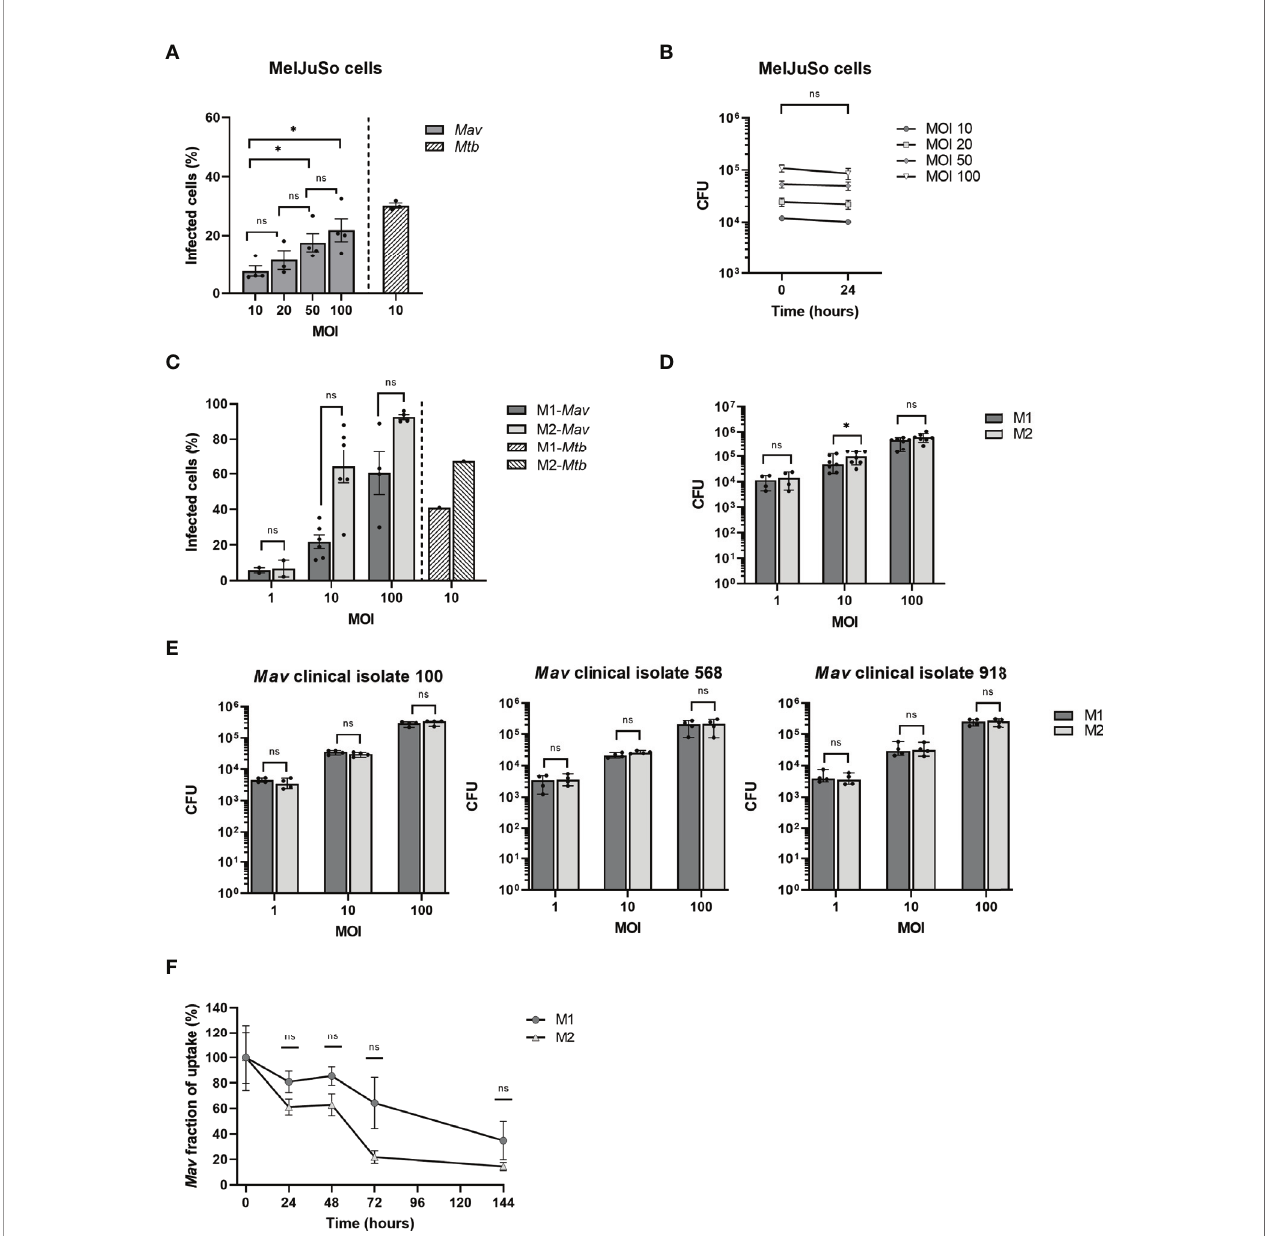
FIGURE 2 | Quanti fi cation of infection with and eradication of intracellular Mav Wasabi and/or clinical isolates by fl ow cytometry and/or CFU enumeration in MelJuSo cells and primary human macrophages. MelJuSo cells were infected with a multiplicity of infection (MOI) range of Mav Wasabi for 1 h. Directly after infection (0 h post-infection), the percentage of infected cells was determined by fl ow cytometry (A) and intracellular bacterial load was quanti fi ed using a CFU assay (B) . Bacterial elimination was monitored by lysing cells for CFU analysis 24 h post-infection (B) . The bars and whiskers represent the mean ± SEM of four different experiments. Differences were tested for statistical signi fi cant using one-way ANOVA with Tukey ’ s multiple comparison testing for infection rates between indicated MOI (A) or two-way ANOVA with Bonferroni ’ s multiple comparison testing for CFU between time points for each MOI (B) . Monocyte-derived human macrophages differentiated into pro-in fl ammatory macrophages (M1) or anti-in fl ammatory macrophages (M2) were infected with a multiplicity of infection (MOI) range (C, D) or an MOI of 10 (F) of Mav Wasabi for 1 h. M1 and M2 macrophages were also exposed to an MOI range of three Mav clinical isolate strains 100, 568, and 918 (E) . Directly after infection (0 h post-infection), the percentage of infected cells was determined by fl ow cytometry (C) and intracellular bacterial load was quanti fi ed using a CFU assay (D, E) . In Mav Wasabi-infected macrophages, eradication of bacteria was monitored over time by lysing cells for CFU analysis at the indicated time points post- infection (F) . Primary human macrophages were obtained from 4 to 7 different donors. The bars/symbols and whiskers/error bars represent the mean ± SEM (C, F) or median ± range (D, E) . Dark and light bars represent M1 and M2, respectively. Hatched bars represent previously reported infection rates in Mtb -infected cells (10:1). Relevance of observed differences in infection rate and intracellular bacteria between M1 and M2 at each MOI was tested using Wilcoxon matched-pairs signed rank tests with Holm-Sidak multiple comparison testing (C – E) , whereas two-way ANOVA with Bonferroni ’ s multiple comparison testing was used for CFU between time points (F) * p < 0.05; ns, non-signi fi